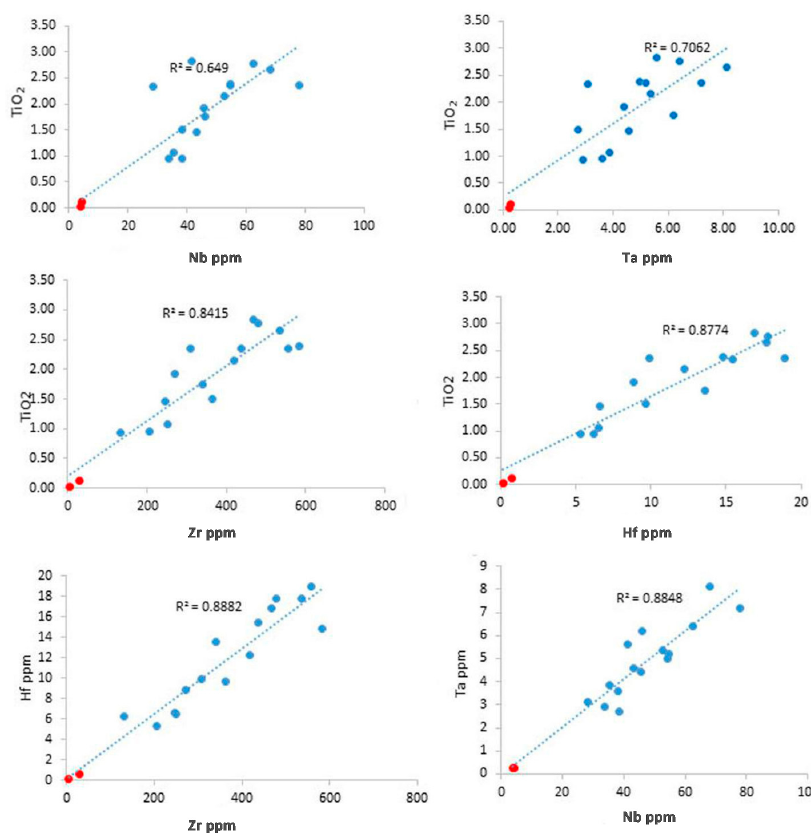
Figure 8. Variation diagrams showing correlations between TiO 2 and trace elements in the Dopolan bauxite deposit. Red circles are carbonate samples, blue circles are bauxite samples.